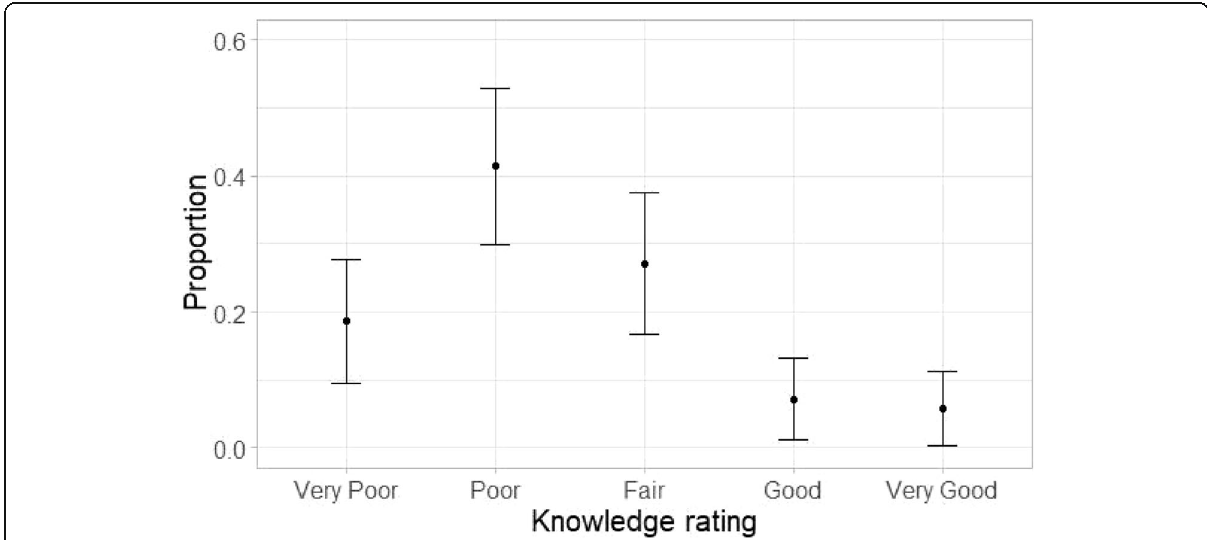
Fig. 4 N = 70. Responses to survey question ‘ How would you rate your knowledge of IR? ’ . A proportion of 0.41 and 0.18 estimate their